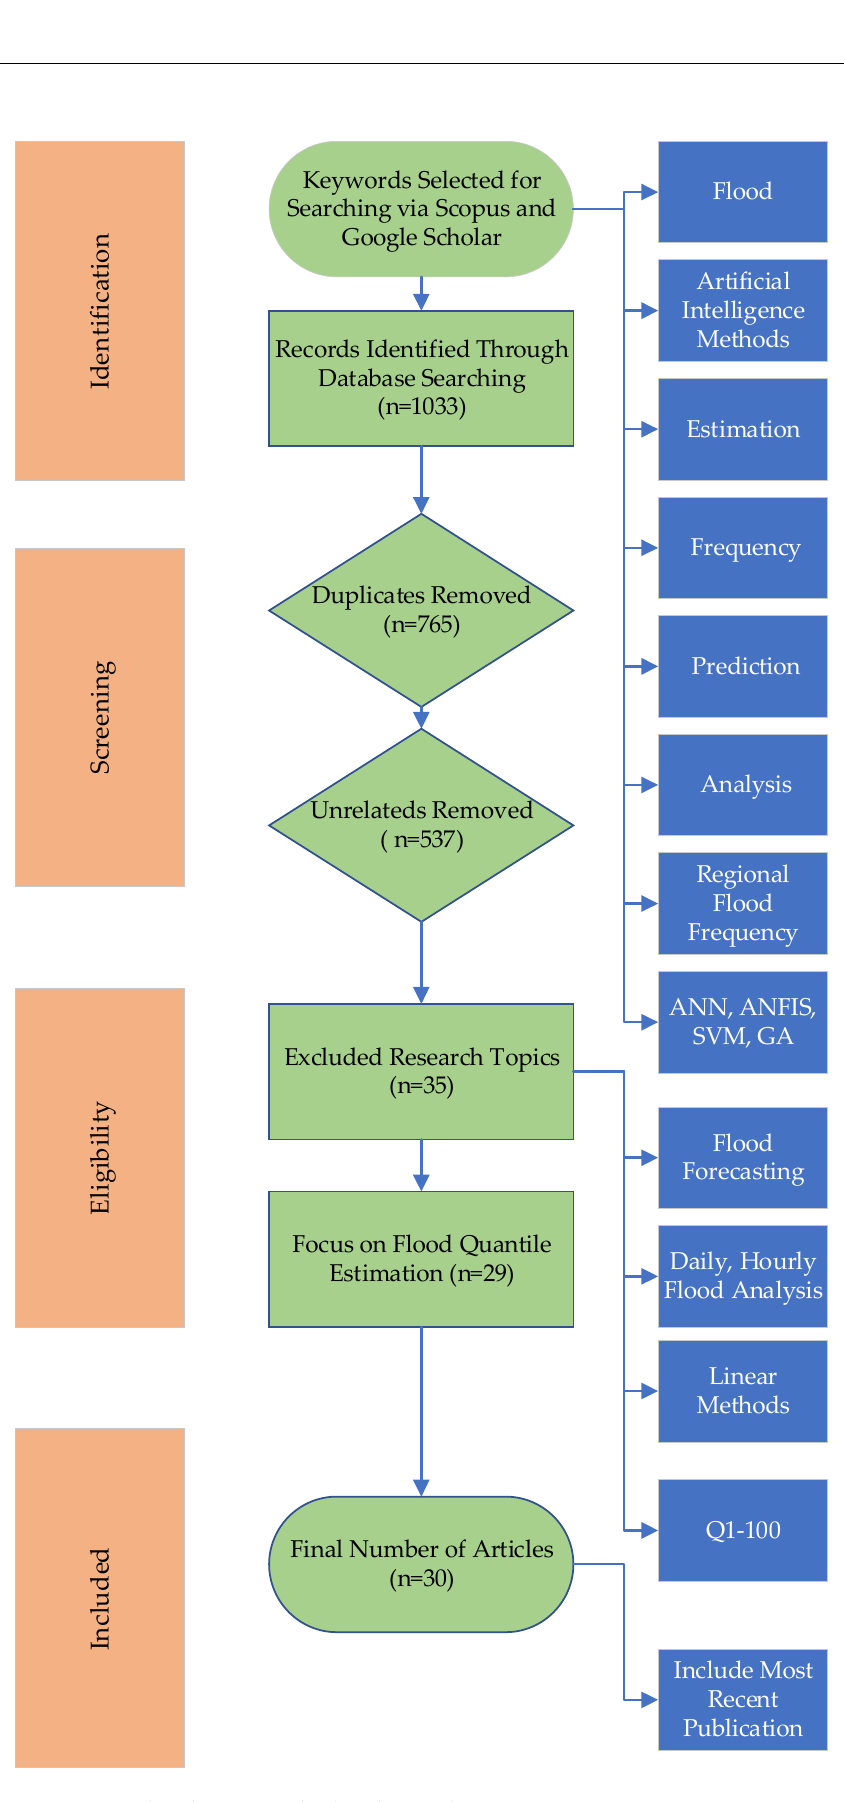
Figure 1. Article selection method in this study.